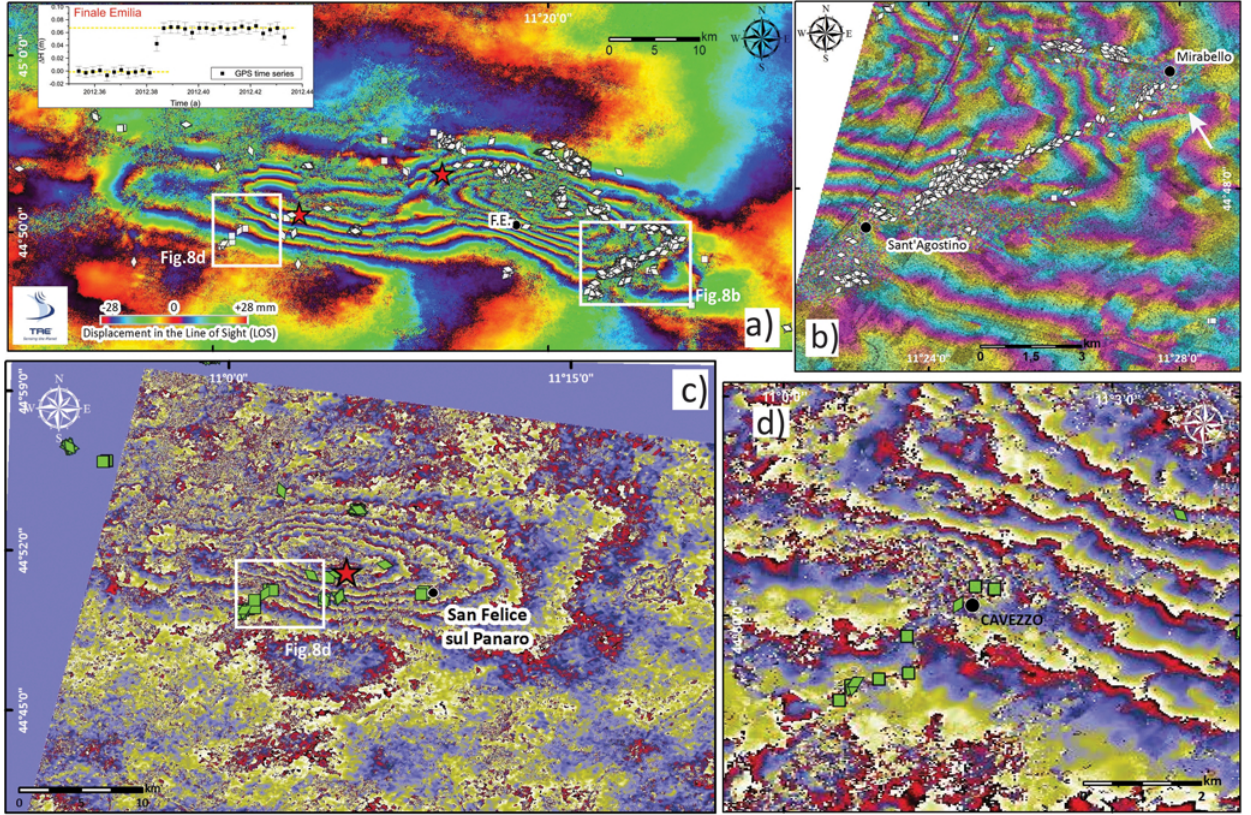
Fig. 8. Inteferograms showing the coseismic deformation field and the local coseismic effects observed at surface. The site effects are marked with diamonds whose major axis parallels the feature strike, and with squares if no strike data are available. (a) Radarsat interfero- gram processed by the T.R.E. company (modified from www.treuropa.com). It represents the cumulative deformation relative to the largest mainshocks (time window: 12 May–5 June). The inset shows the data from continuous GPS station located at Finale Emilia indicating a clear coseismic height variation of about 6.5cm on 20 May (Baldi et al., 2009); (b) COSMO SkyMed image showing the easternmost deformation field of the 20 May mainshock (red star). White arrow points to the abrupt deviations of the fringes strike; (c) COSMO SkyMed image of the full deformation field of the 29 May mainshock (red star). Diamonds and squares symbols locate the effects observed following the 29 May event (newly formed and/or reactivation of 20 May features); (d) enlargement of the southwest portion of interferogram in (c) . All COSMO interferograms were processed by the Sigris Project (Pezzo et al.,